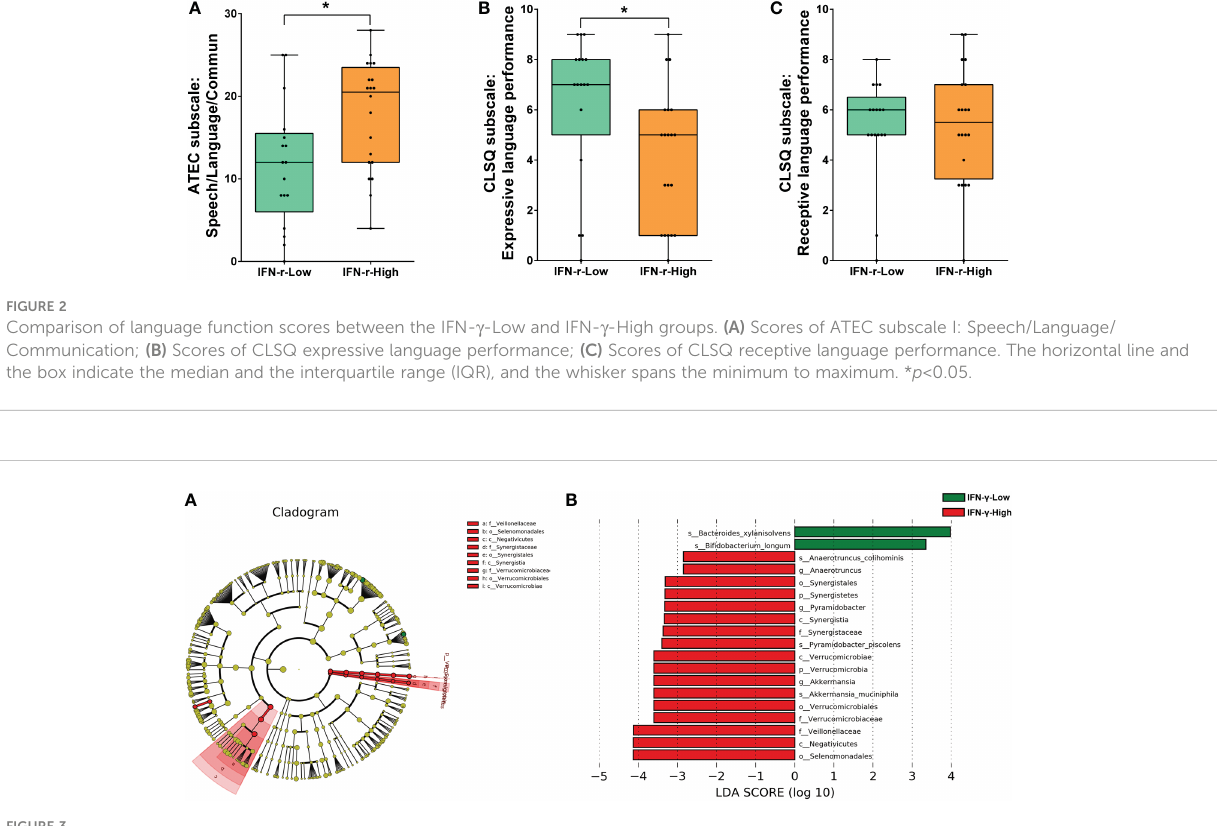
FIGURE 3 Cladograms generated by LEfSe and LDA scores for bacterial taxa differentially abundant between groups. (A) Cladograms indicating differences in the bacterial taxa between the IFN- g -Low and IFN- g -High group. Green and red nodes indicate taxa that were enriched in the IFN- g -Low group and the IFN- g -High group, respectively. (B) LDA scores for differentially abundant bacterial taxa. Only taxa having a p <0.01 and LDA>2 are shown. Positive LDA scores indicate the taxa enriched in the IFN- g -Low (IFN- g -L) group (green), while negative LDA scores indicate the taxa enriched in the IFN- g - High (IFN- g -H) group (red),